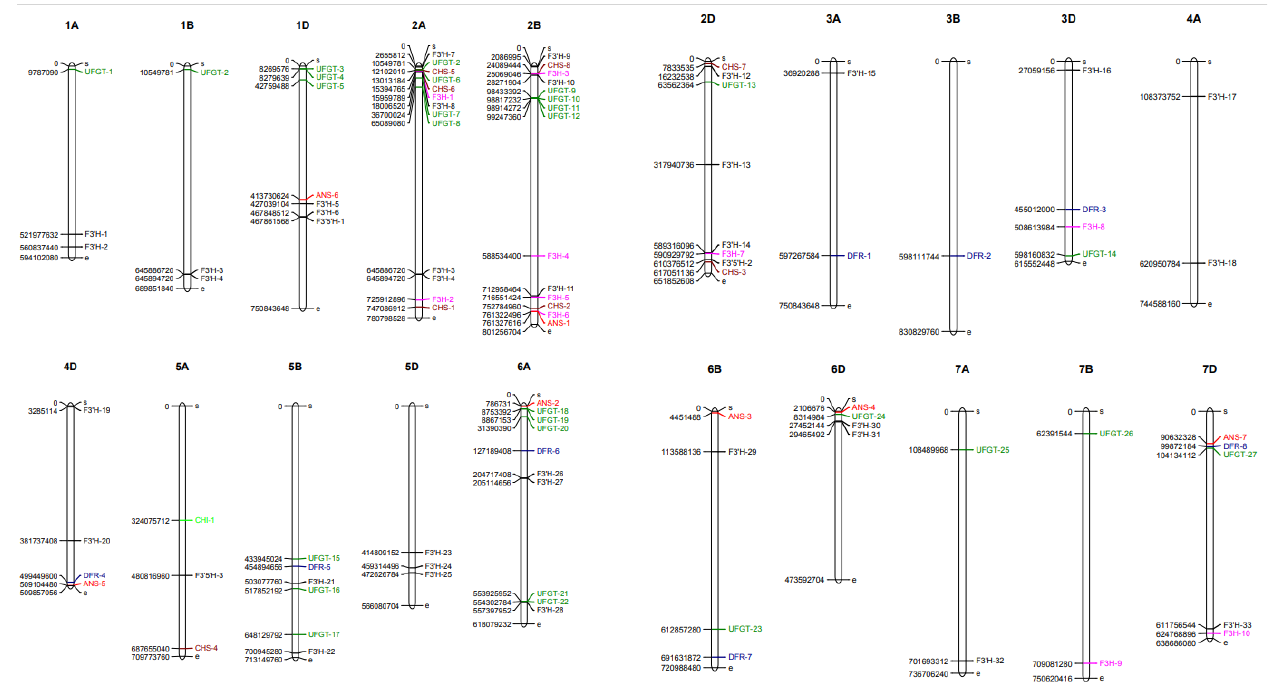
Figure 4. Chromosomal localization of anthocyanin biosynthetic DEG isoforms of the wheat ge- nome.